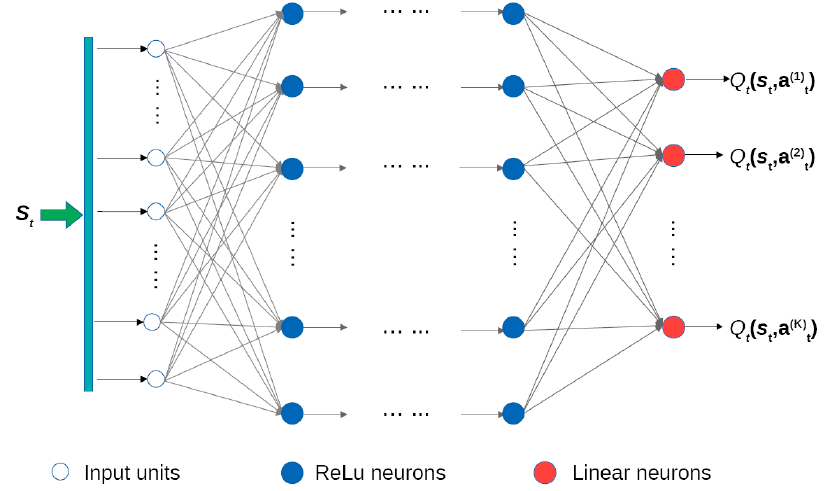
Figure 7. Architecture of the designed Deep Q-Network [35].